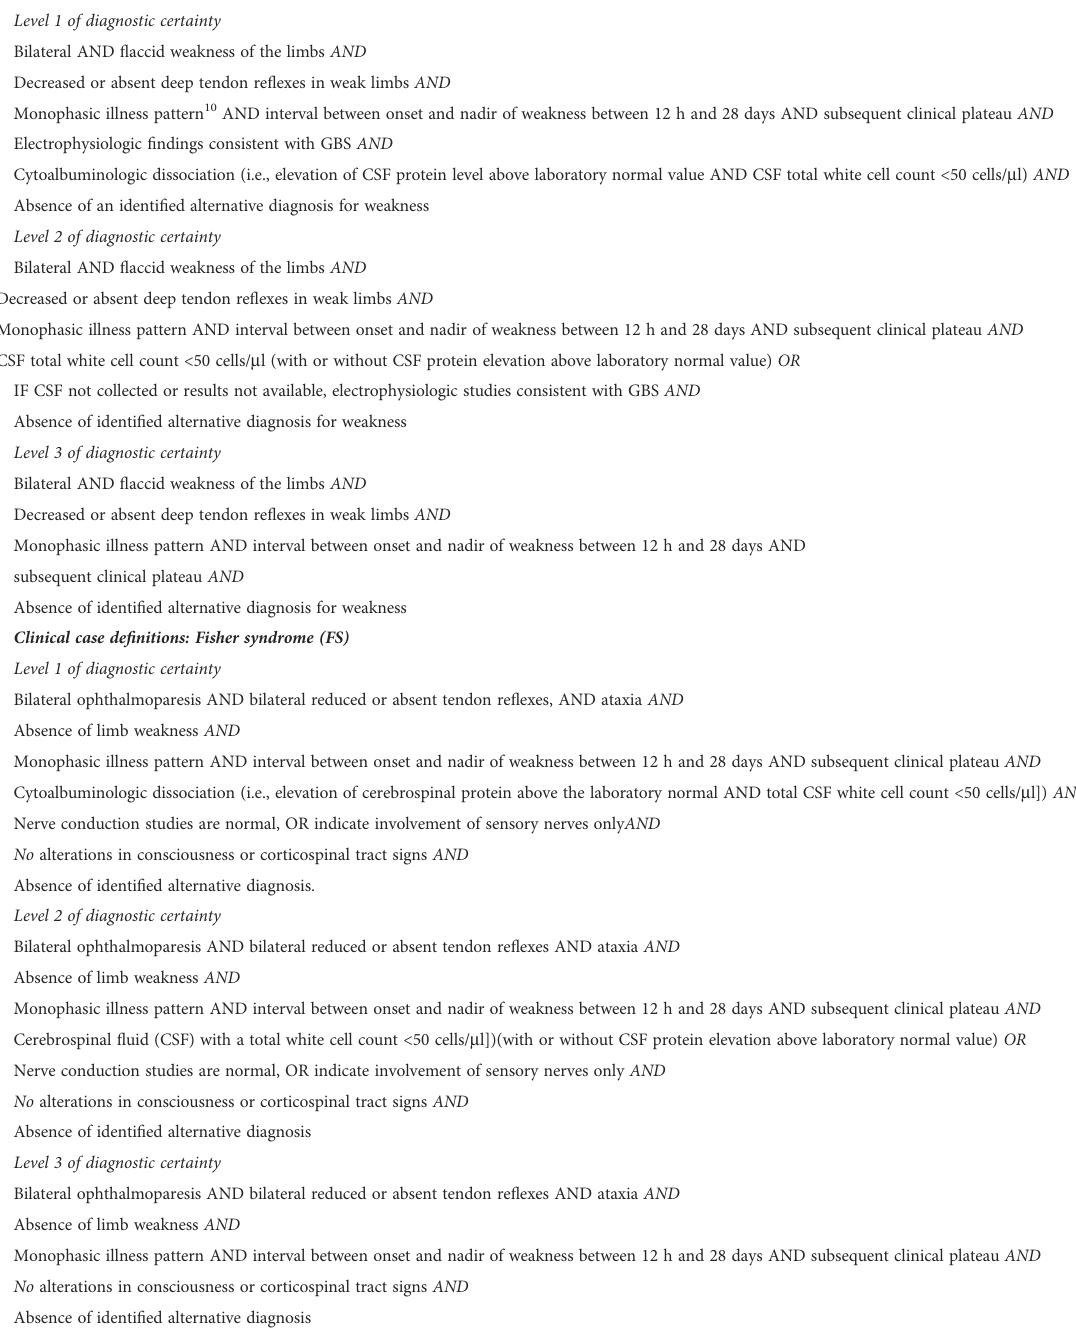
TABLE 1 The Brighton Criteria for diagnosis of GBS and Fisher